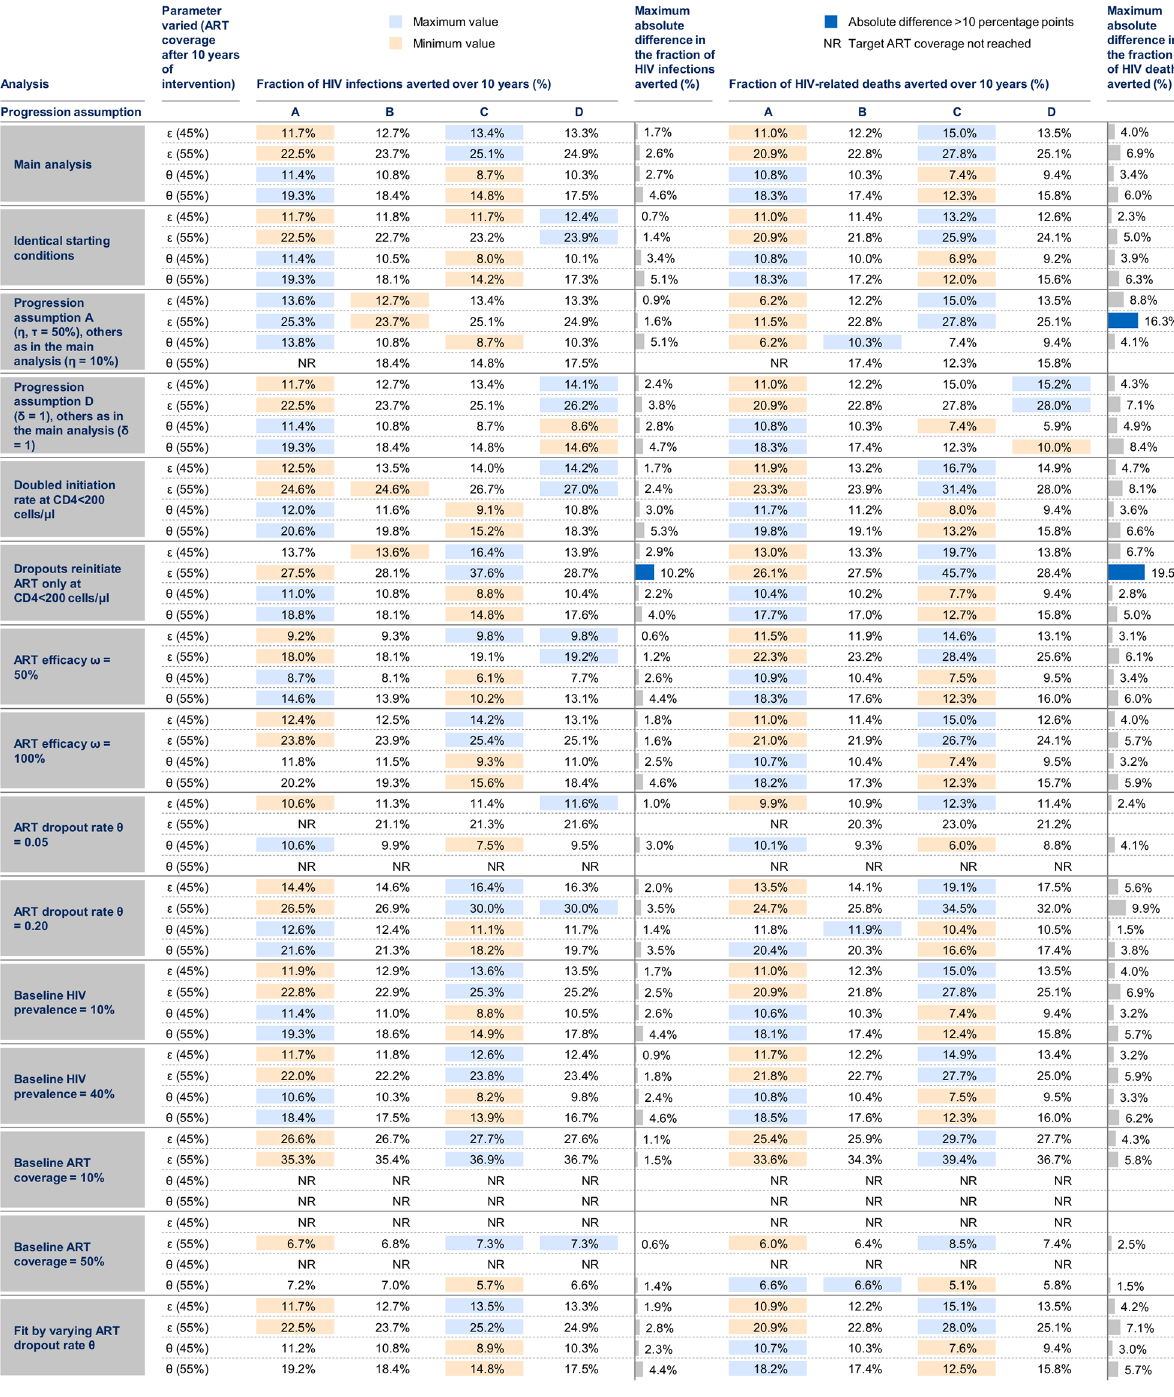
Fig 2. Summary of results. Each model reaches the specified ART coverage target (in brackets) 10 years after the intervention, which is achieved by either increasing the ART uptake rate ( ε ) or decreasing the ART dropout rate ( θ ). Maximum absolute differences are the differences between the minimum and maximum estimates across progression assumptions; these are only calculated when estimates are available for all 4 progression assumptions. Blue bars indicate that the absolute difference between progression assumptions in the fraction averted is greater than 10 percentage points. NR: the target ART coverage could not be reached for this progression assumption and the specified